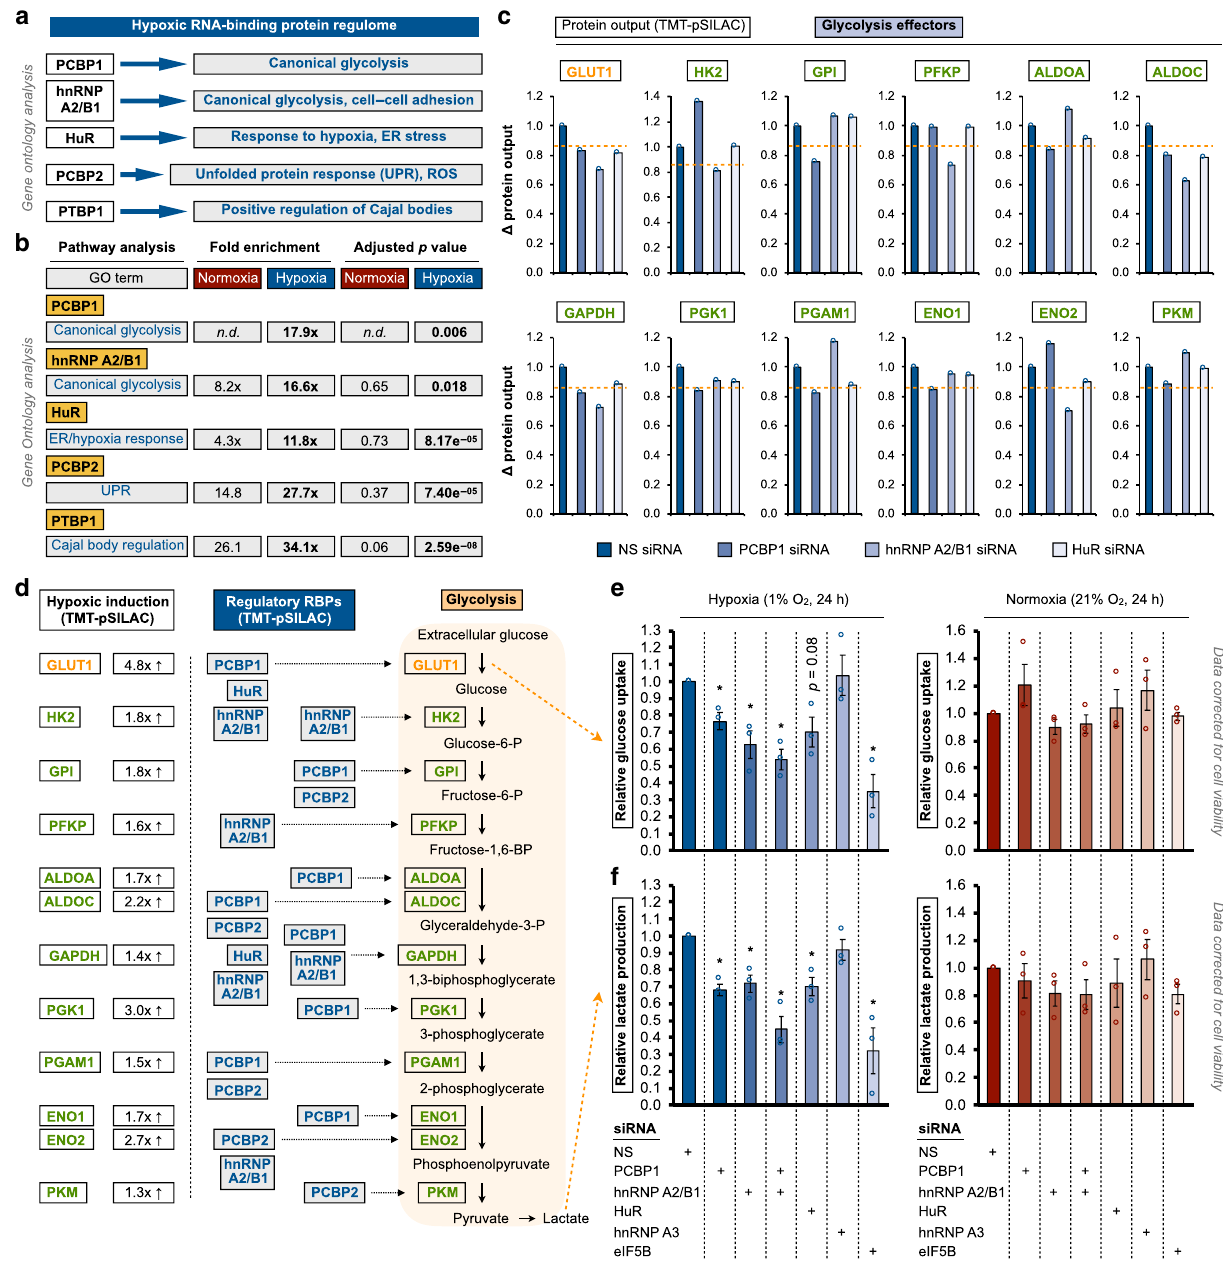
Fig. 3 Oxygen-dependent recon fi guration of RBP-regulated cellular networks. a Hypoxia-induced rewiring of RBP-regulated processes by Gene Ontology (GO) pathway enrichment analysis. b GO analysis of representative enriched biological processes for downregulated proteins when indicated RBPs are silenced. c Protein output regulation of each glycolytic effector by the hypoxia-adaptive RBPs PCBP1, hnRNP A2/B1, and HuR, as determined by TMT- pSILAC (three independent experiments pooled into a single sample for measurement). Orange dotted line represents the MS regulatory threshold, validated empirically at the steady-state protein level by immunoblot, and at the translation ef fi ciency level by qRT-PCR of ribosome density fractions. d Left panel: protein expression of glycolytic effectors are induced under hypoxic conditions (con fi rmed by TMT-pSILAC). Synergistic regulation of glycolytic proteins (right panel) by hypoxia-adaptive RBPs (middle panel) as determined by TMT-pSILAC analysis. Measurements of e glucose uptake and f lactate production in U87MG treated with indicated siRNAs (for 48 h prior to following experimentation). Color scheme: red, normoxia; blue, hypoxia. NS: non-silencing. Asterisk denotes statistical signi fi cance calculated using two-sided Student ’ s t -tests compared to NS control. Exact p values e : PCBP1 siRNA ( p = 0.04), hnRNP A2/B1 siRNA ( p = 0.04), PCBP1 + hnRNPA2/B1 siRNA ( p = 0.02), eIF5B siRNA ( p = 0.02). Exact p values f : PCBP1 siRNA ( p = 0.01), hnRNP A2/B1 siRNA ( p = 0.03), PCBP1 + hnRNPA2/B1 siRNA ( p = 0.02), HuR siRNA: ( p = 0.03), eIF5B siRNA ( p = 0.04). Data represent mean ± SEM (error bars) of three independent experiments. Source data are provided as a Source data fi